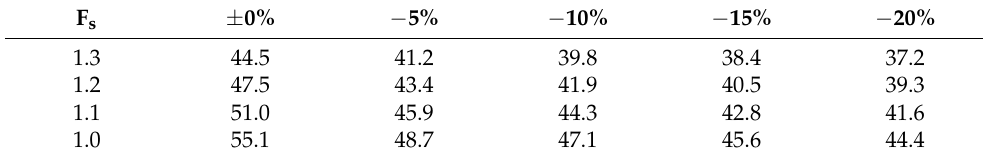
Table 4. Slope angles corresponding to different reduction degrees and safety factors.